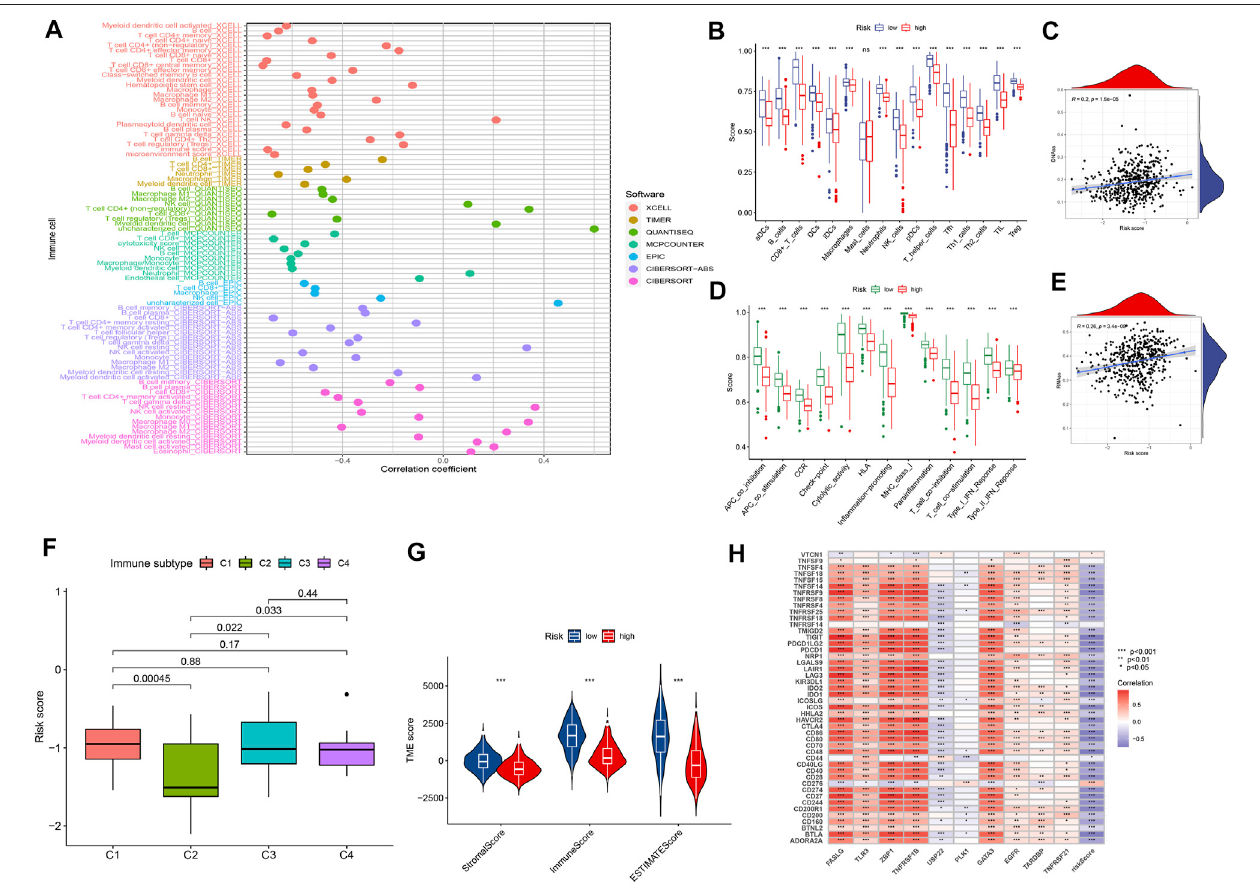
FIGURE 7 | The tumor microenvironment characteristics between risk subgroups. (A) Immune cell in fi ltration based on XCELL, TIMER, QUANTISEQ, MCP- counter,CIBERSORT,CIBERSORT-ABS,andEPICalgorithmsbetweenhigh-andlow-riskgroups. (B,D) ComparisonofssGSEAscoresbetweenthetworiskgroupsin the TCGA cohort. (G) ESTIMATE scores, stromal scores, and immune scores for different risk statuses. (C,E,F,H) Correlation between risk scores and RNAs, DNAs, immune subtype, and immune